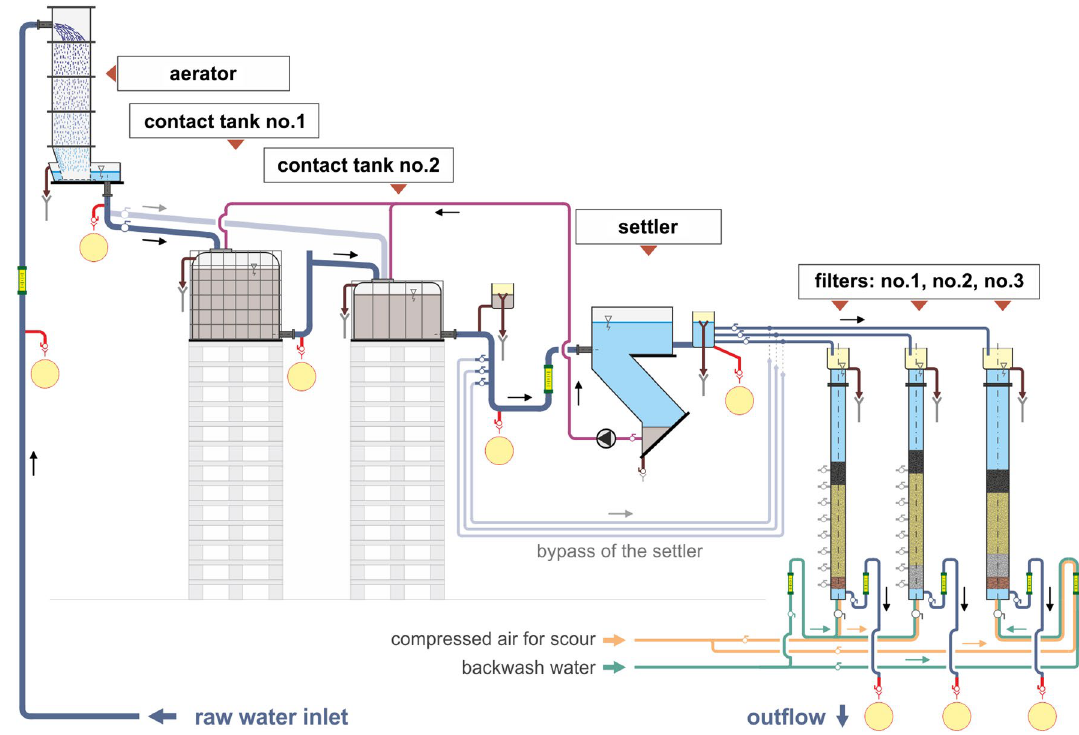
Fig. 1 The diagram of the pilot station